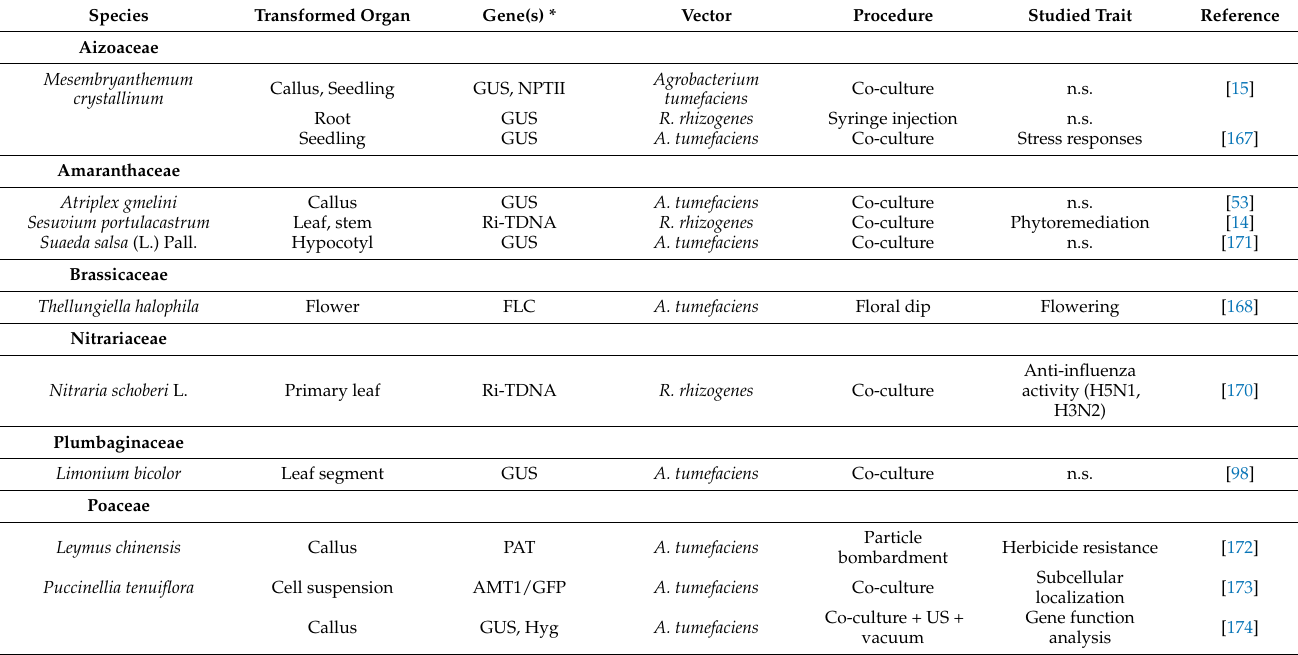
Table 3. Transgenesis experiments reported in halophyte